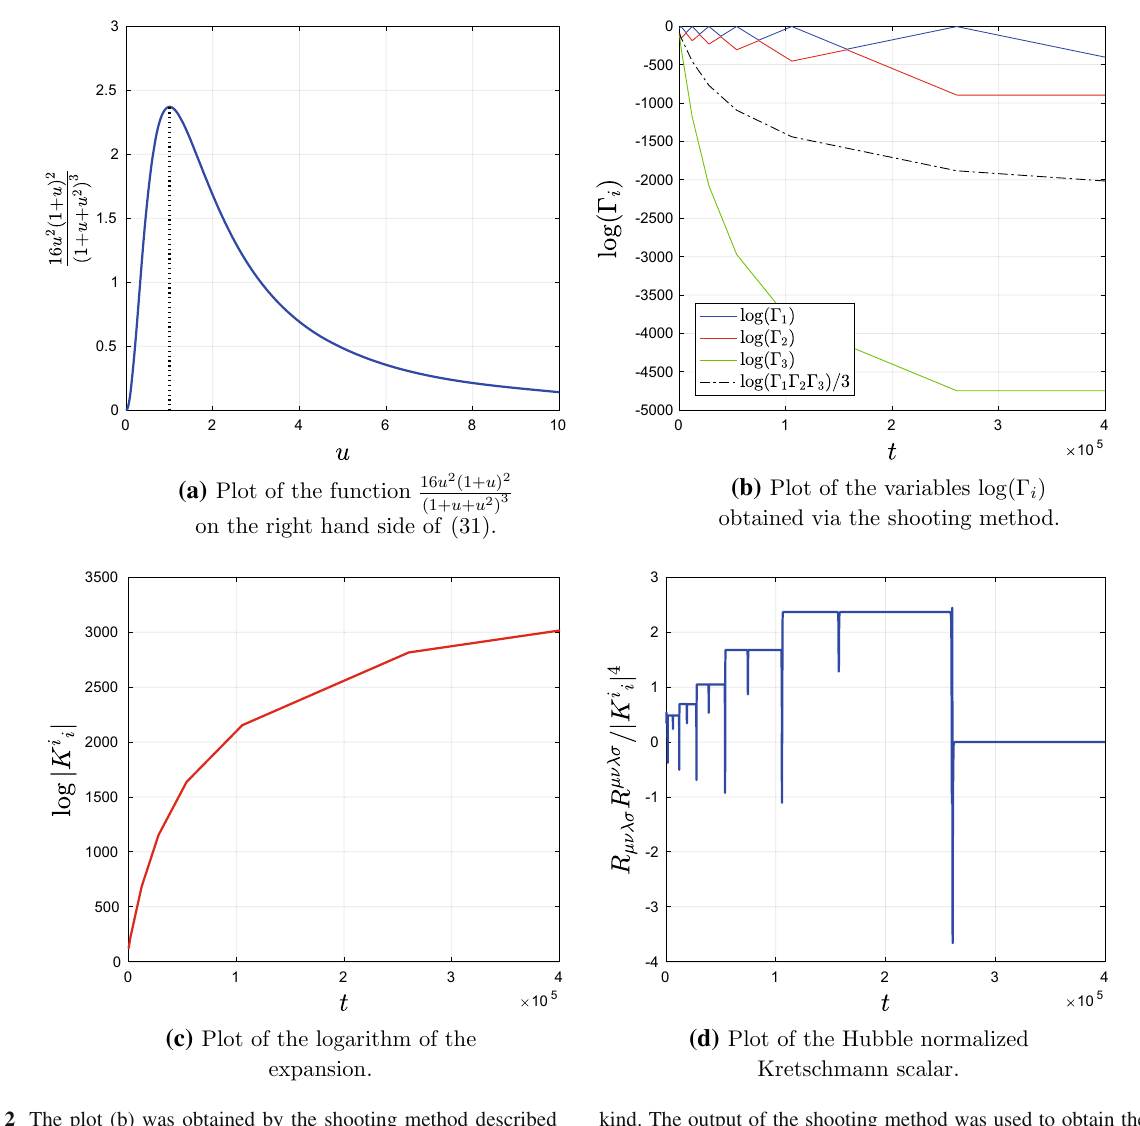
(b) Plot of the variables log(Γ i ) obtained via the shooting method.